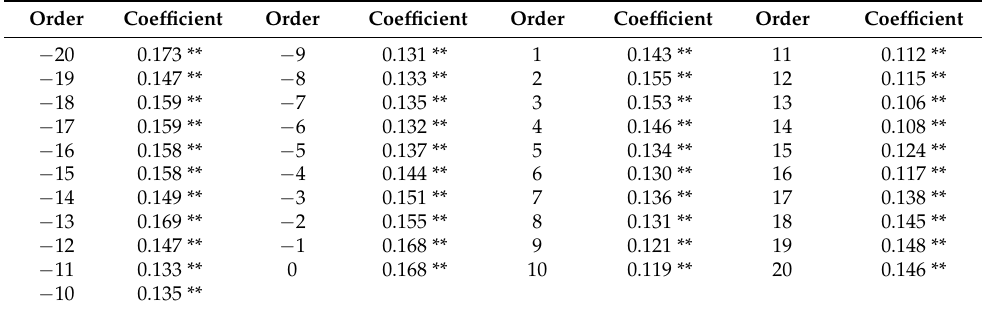
Table 2. Correlation coefficient for keywords